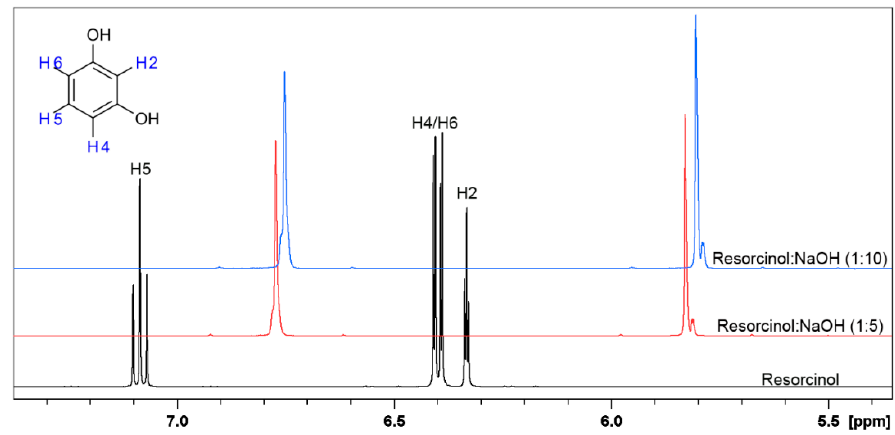
Figure 8. 1 H-NMR spectra of resorcinol in D 2 O (black line) and in the presence of NaOH in D 2 O in the molar ratio 1:5 (red line) and 1:10 (blue line), respectively.